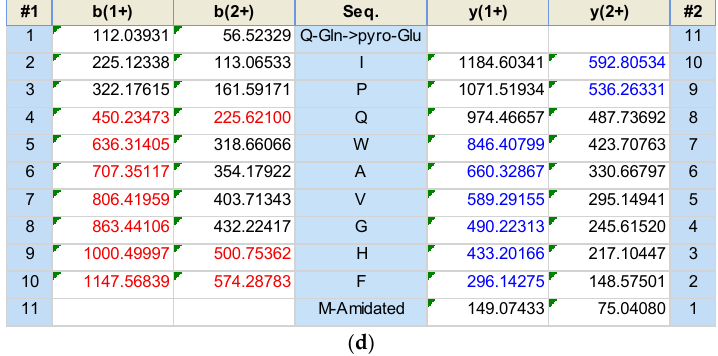
Figure 4. Liquid chromatography coupled tandem mass spectrometry (LC/MS/MS) spectra and predicted b- and y-ion MS/MS fragment ion series of bombesin-OS and bombesin-PE. ( a ) Annotated tandem mass spectrometry (MS/MS) fragmentation spectrum of bombesin-OS; ( b ) Predicted singly and doubly charged b- and y-ions arising from MS/MS fragmentation of bombesin-OS. The observed b- and y-ions are showed in red and blue, respectively; ( c ) Annotated MS/MS fragmentation spectrum of bombesin-PE; ( d ) Predicted singly and doubly charged b- and y-ions arising from MS/MS fragmentation of bombesin-PE. The observed b- and y-ions are showed in red and blue, respectively.